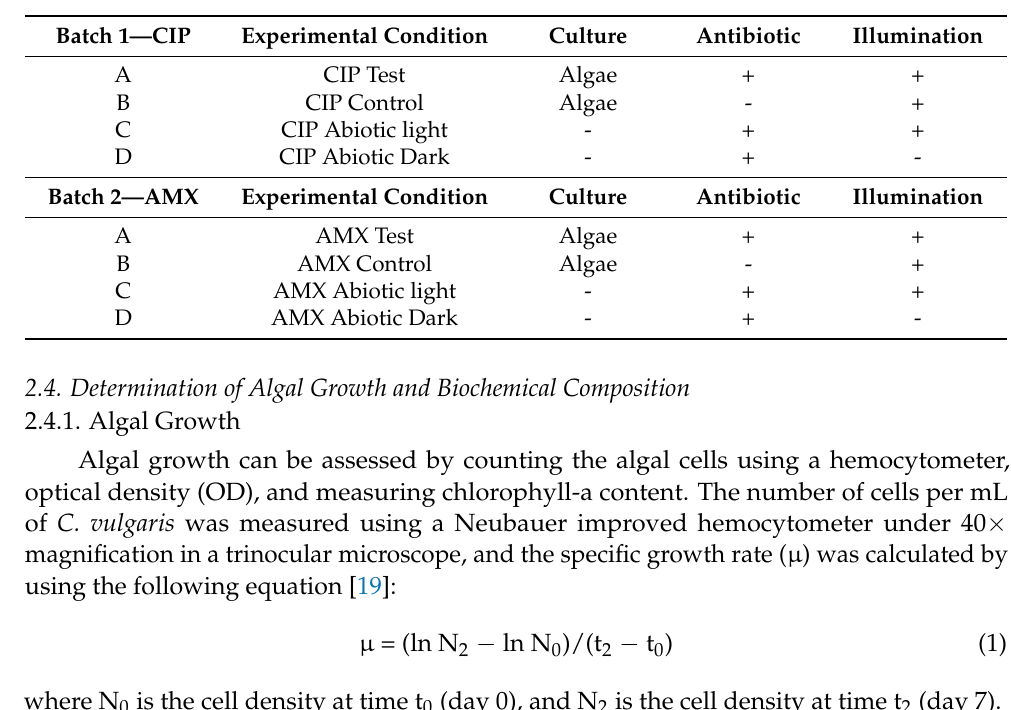
Table 1. Experimental setup conditions and their respective